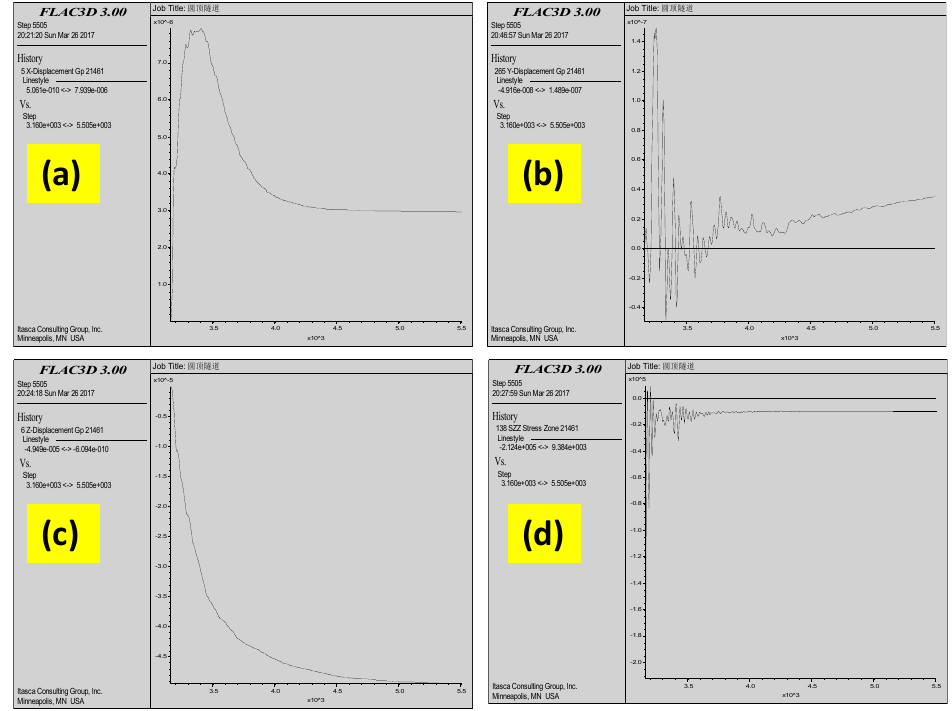
Figure 5. Stress and displacement variation of ID 21461: ( a ) X-direction displacement, ( b ) Y-direction displacement, ( c ) Z-direction displacement, and ( d ) vertical stress.